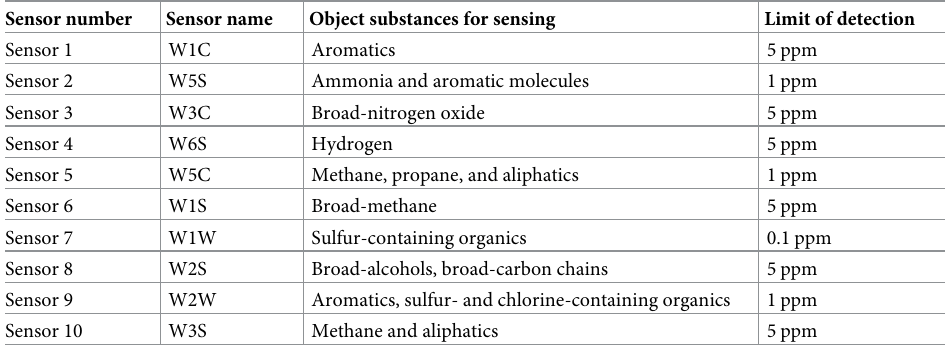
Table 1. eNose sensor functionalization.